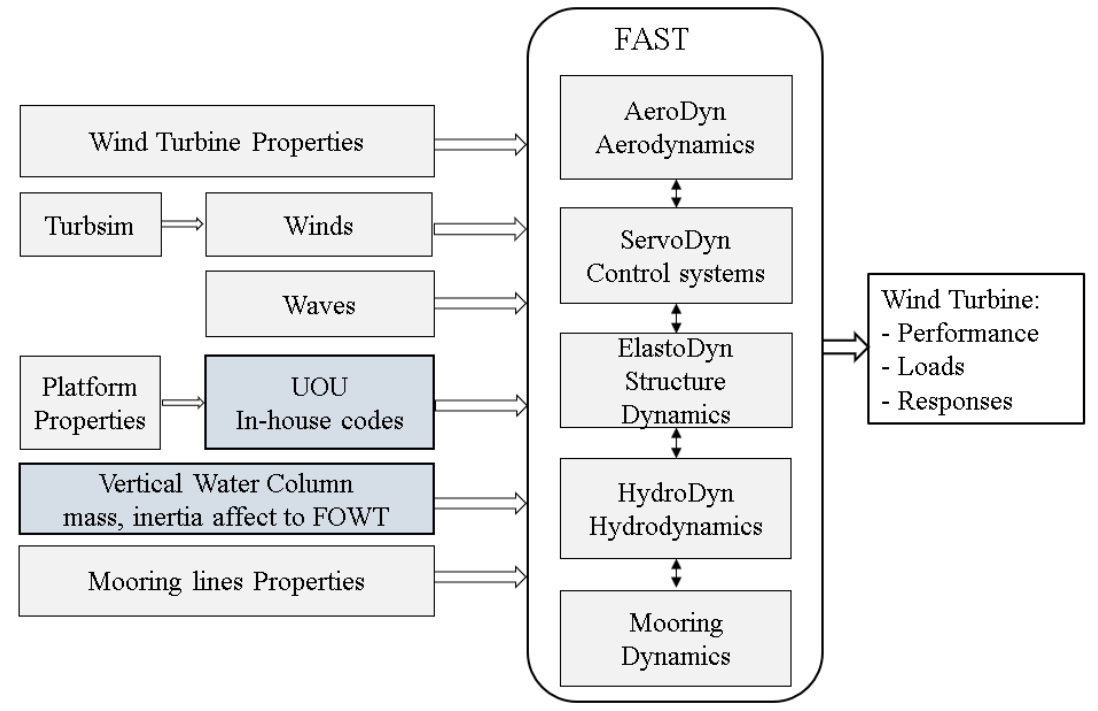
Figure 6. Time domain analysis of fully coupled hydro-aero-servo-elastic dynamic model of a total FOWT system. Table 3. Design Load Cases (DLCs) [25].